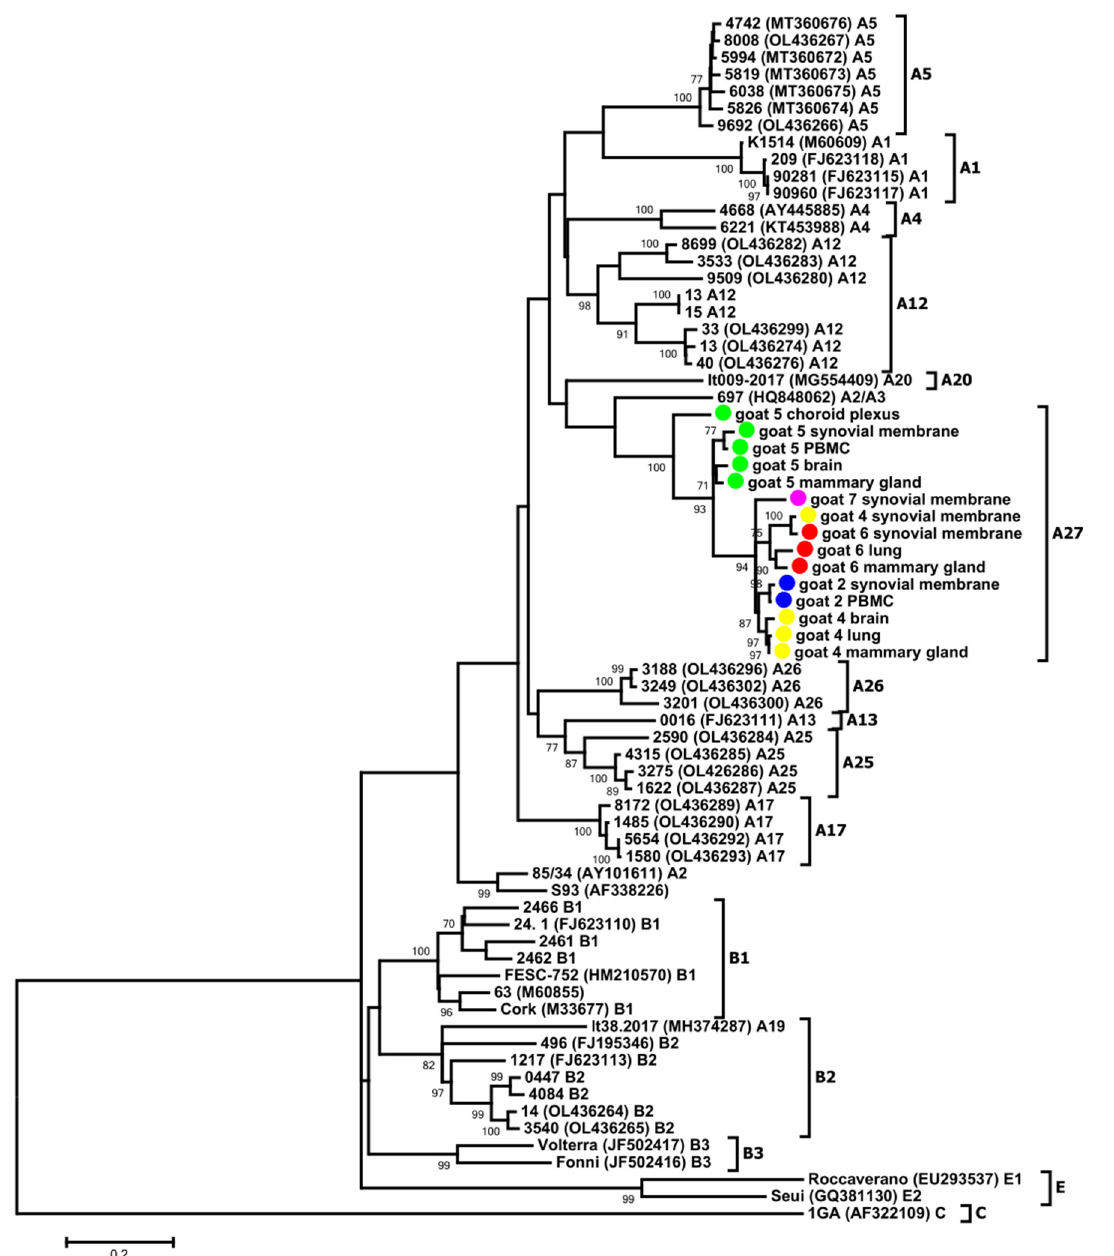
Figure 2. Maximum-likelihood phylogenetic tree based on the alignment of the CA fragment of the gag gene. Sequences from this study are labeled by black circles. Numbers at the branches in- dicate the percentage of bootstrap values obtained from 1000 replicates. Bootstrap values > 70% are shown. In the present study, the SRLV subtypes found by Colitti et al. [23] were renamed from A18 to A19 and from A19 to A20, and the subtypes found by Olech et al. [8] were renamed from A23 to A25 and from A24 to A26; goat 2—Blue, goat 3—Black, goat 4—Yellow, goat 5—Green, goat 6—Red, goat 7—Pink.